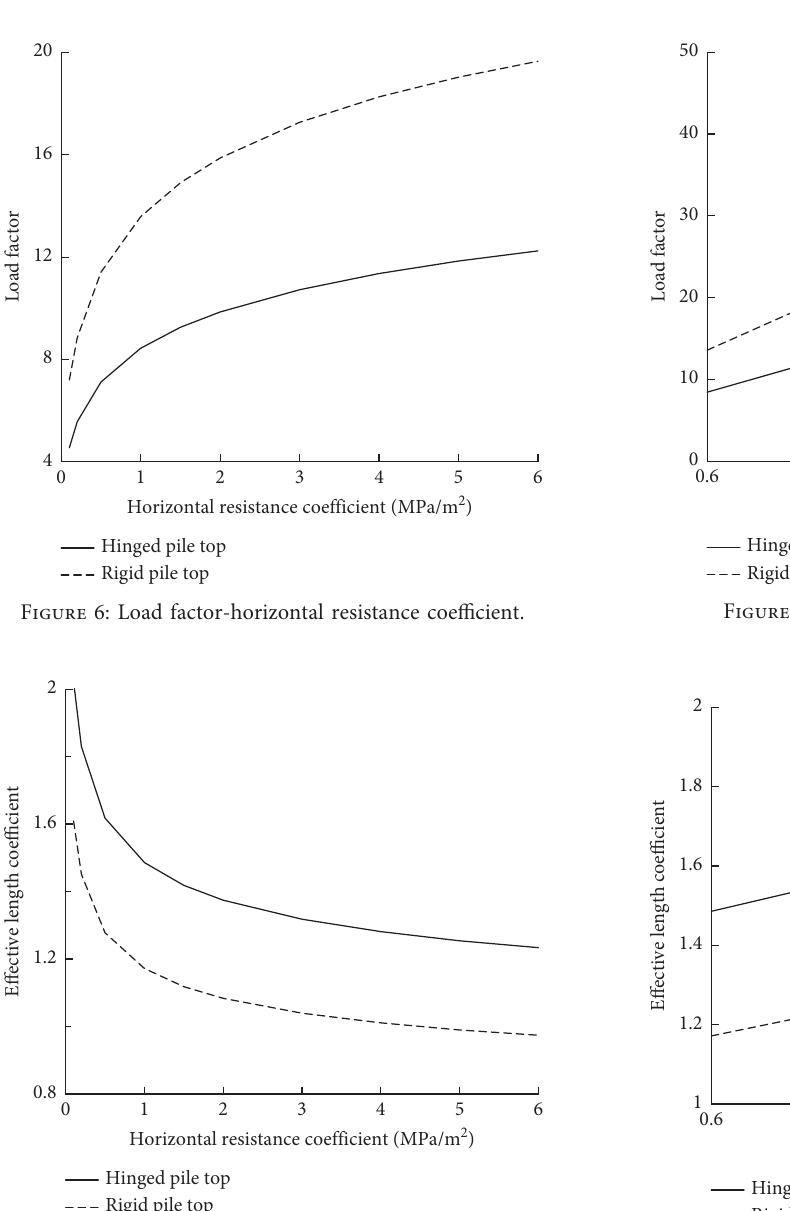
Figure 7: Effective length coefficient-horizontal resistance coefficient.